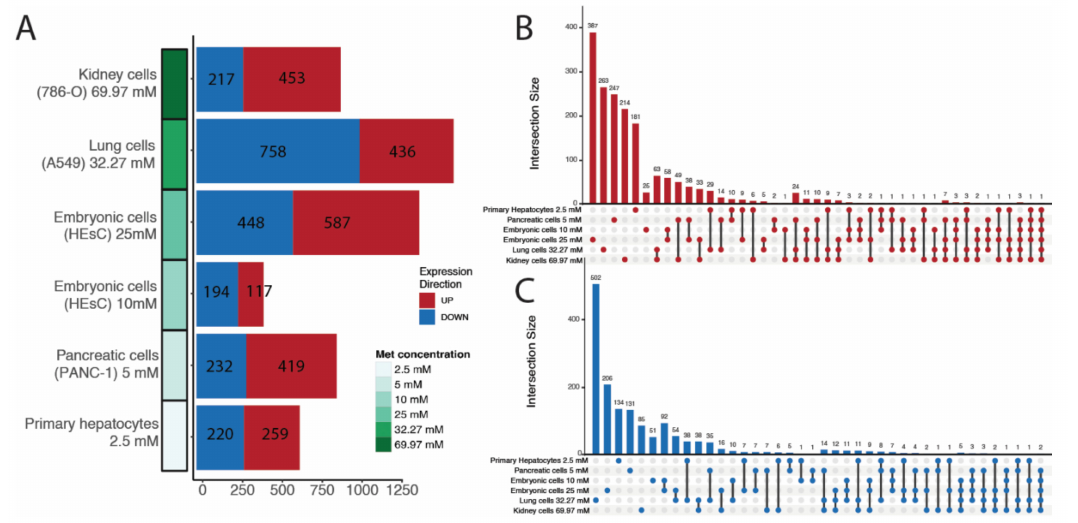
Figure 1. ( A ) Differential lncRNA isoforms counted per series using a cutoff of p -value < 0.05 and absolute log2foldchange > 0.5. Series are ordered according to descending metformin concentration. Number of upregulated lncRNA isoforms shown in dark red and number of downregulated lncRNA isoforms shown in dark blue. Upset plots of up- ( B ) and downregulated ( C ) lncRNA isoforms which intersect between series.